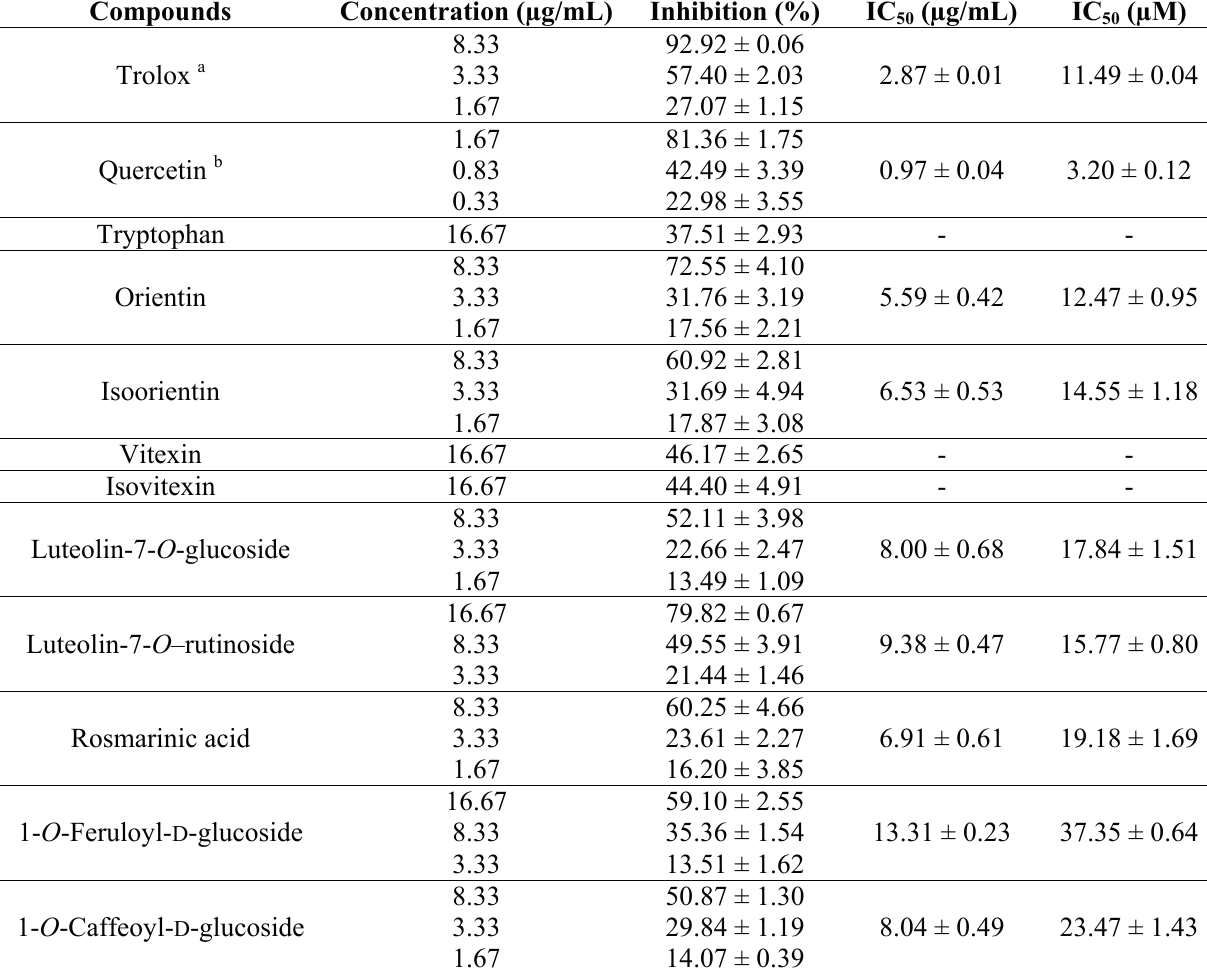
Table 5. Antioxidant effects of the constituents isolated from the Colocasia esculenta (L.) Schott on inhibition of the ABTS +